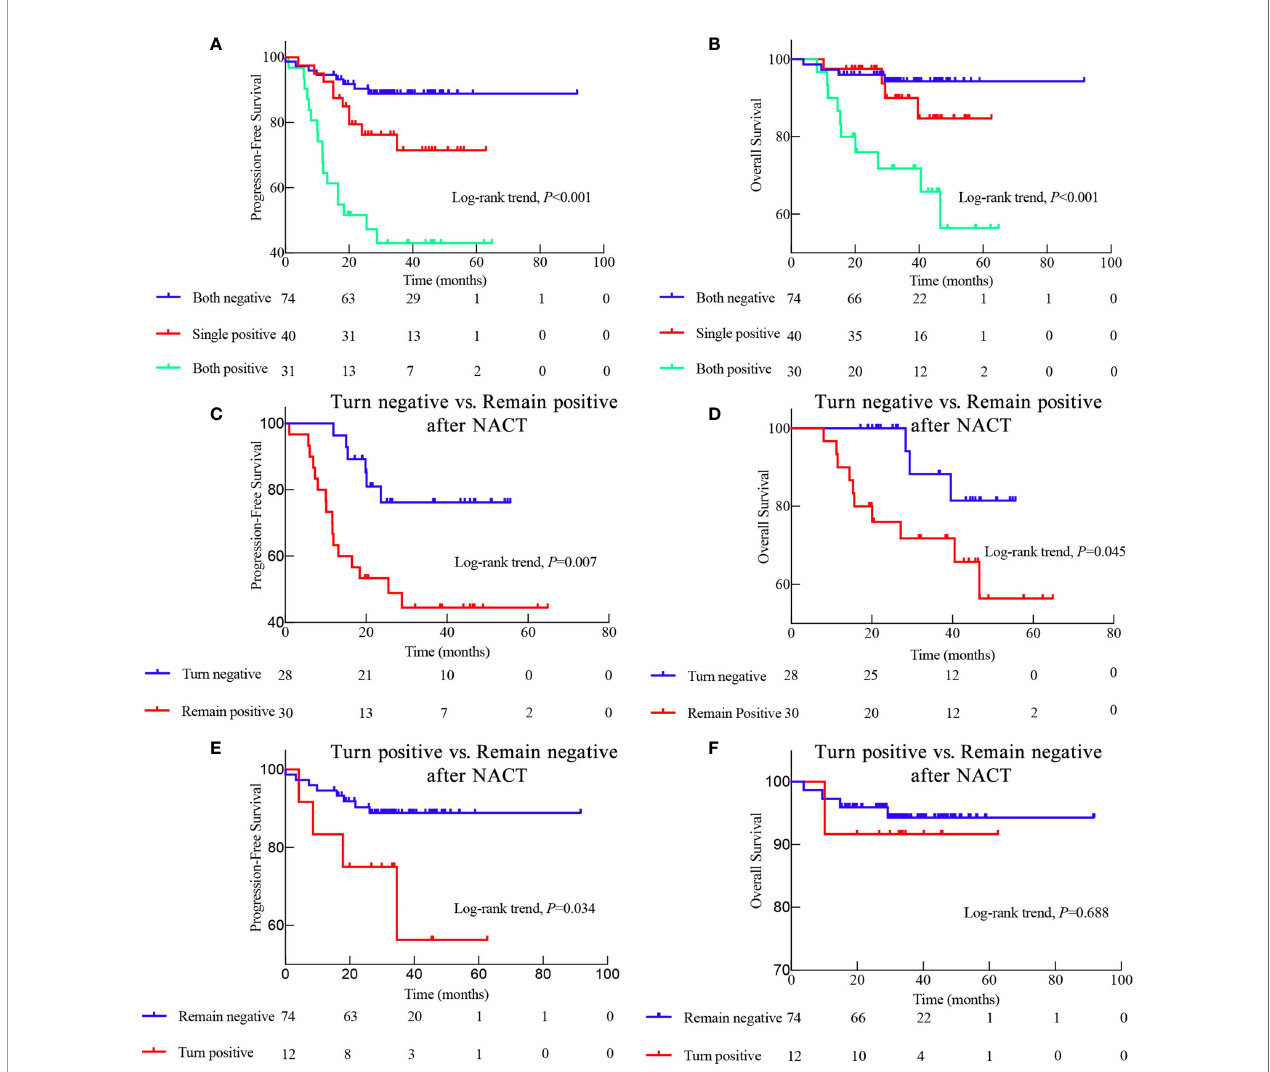
FIGURE 3 | Kaplan-Meier survival curves displaying the progression-free survival (PFS) and overall survival (OS) of patients with different EBV status during neoadjuvant chemotherapy (NACT). (A) PFS and (B) OS of patients with different EBV status throughout NACT as follows: Both negative means EBV DNA-negative before and after NACT; Single positive means EBV DNA-positive either before or after NACT; Both positive means EBV DNA-positive both before and after NACT; (C) Comparison of the PFS and (D) OS between patients whose EBV DNA status switched from positive to negative after NACT and those who remained EBV DNA- positive after NACT; (E) Comparison of the PFS and (F) OS between patients with EBV DNA status changing from negative to positive and those who remained EBV DNA-negative after